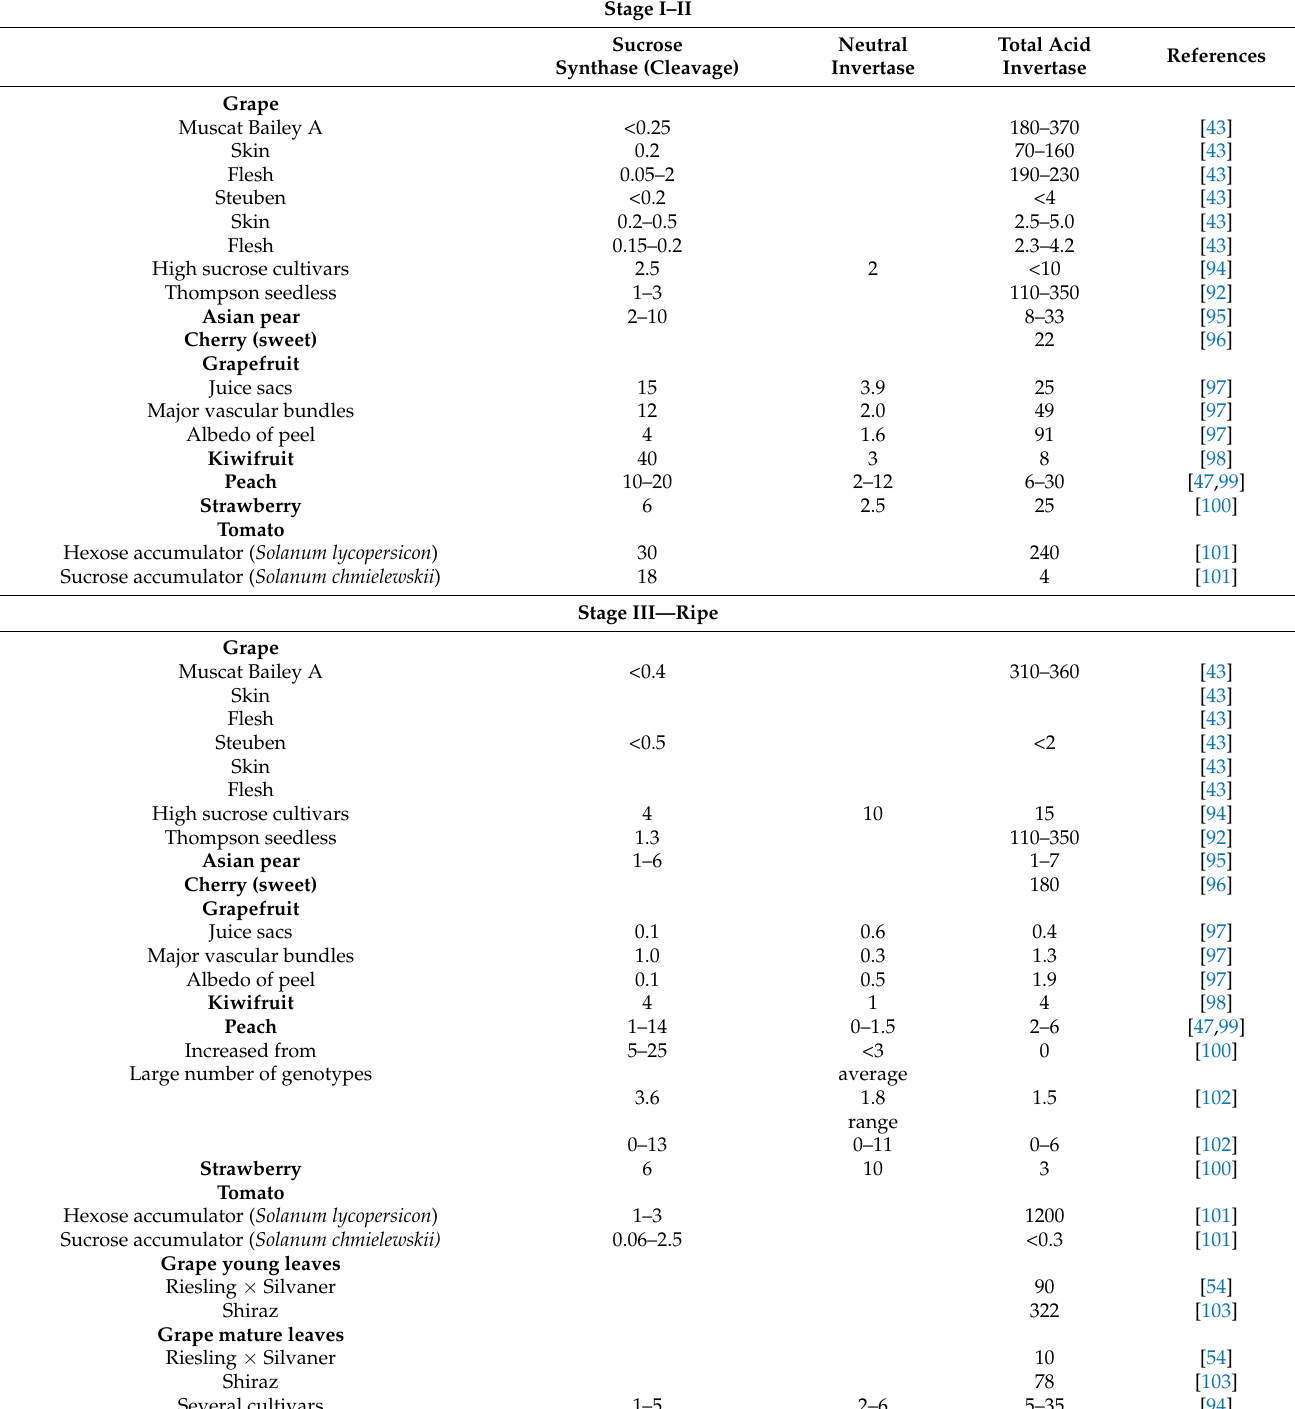
Table 2. Typical approximate activities of sucrose synthase and the invertases ( µ mol g − 1 FW h − 1 ) in the pericarp, and in some cases skin and flesh, and leaves of grape and the flesh of some other fruits. Both Muscat Bailey A and Steuben are interspecific